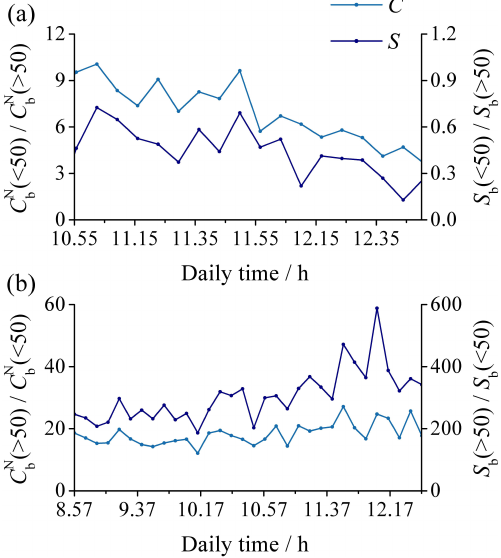
Fig. 6. (a) Ratio of the number concentrations of aerosols smaller than 50nm ( C N ( < 50)) to those of bigger ones ( C N ( > 50)), and b b ratio of the total surface area of all particles smaller than 50nm ( S b ( < 50)) to the total surface area of all particles bigger than 50nm ( S b ( > 50)) in a volume unit for the measurement in summer 2009 and (b) ratio of the number concentrations of aerosols larger than 50nm ( C N ( > 50)) to those of smaller ones ( C N ( < 50)), and ratio b b of the total surface area of all particles larger than 50nm ( S b ( > 50)) to those smaller than 50nm ( S b ( < 50)) in a volume unit for the measurement in winter